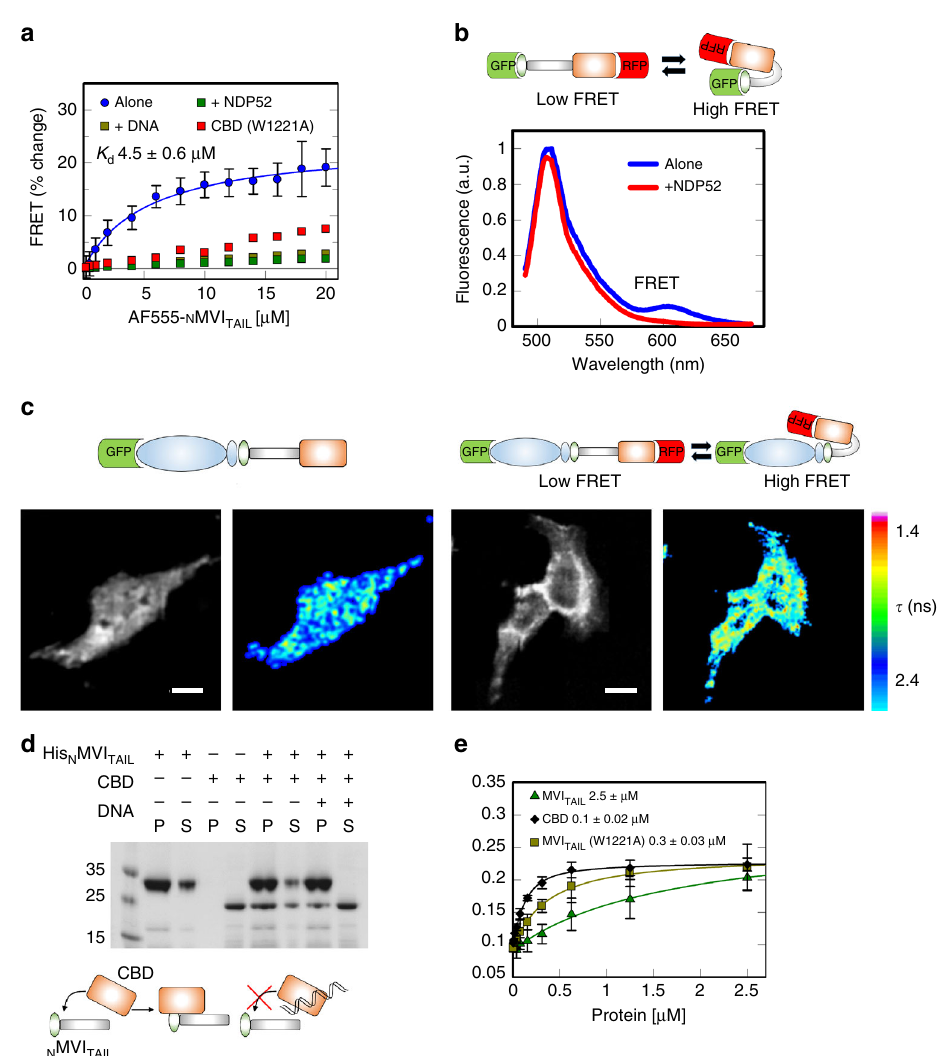
Fig. 3 Regulation of myosin VI backfolding. a FRET titration of N MVI TAIL against CBD (1 μ M) or CBD(W1221A) in the presence of DNA, or NDP52, at 10 μ M. Data fi tting was performed as described in Methods. NDP52 and CBD(W1221A) data are plotted as disconnected points due to low signal change. See Supplementary Fig. 4a – c for raw intensity data. b Representative fl uorescence spectra of 2 μ M GFP-MVI TAIL -RFP ± 15 μ M NDP52. c FLIM measurements of in vivo MVI conformational dynamics. Above, schematic showing the constructs. Left, GFP intensity and lifetime images. Right, intensity and lifetime images of the biosensor. Lifetime ( τ ) is represented by a pseudocolor scale. Scale bar is 20 μ m. d Pull-down of CBD by His-tagged N MVI TAIL both at 10 μ M ± 20 μ M 40 bp DNA. P and S represent pellet and supernatant fractions. e Fluorescence anisotropy titrations of MVI domains against a 40 bp FAM